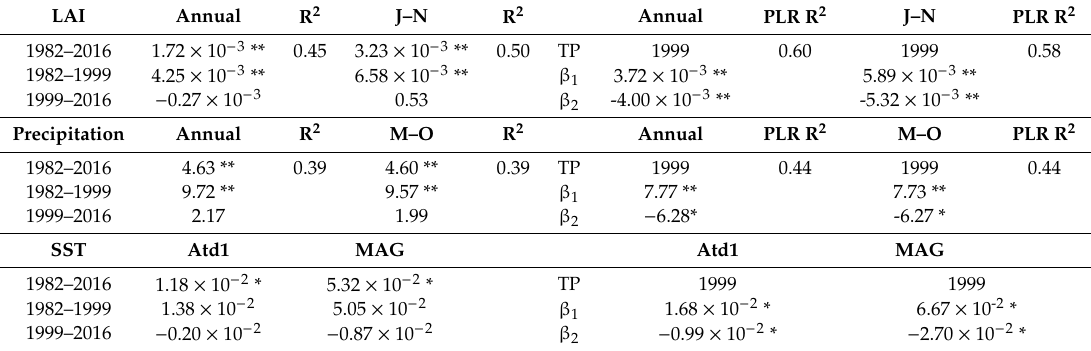
Table 2. PLR analysis of LAI, precipitation, and SST indices between 1982 and 2016 with turning point (TP) at 1999. The coe ffi cient of determination R 2 indicates the linear regression and PLR regressions of the time series between 1982 and 2016. β 1 and β 2 are the regression coe ffi cients of the PLR method.